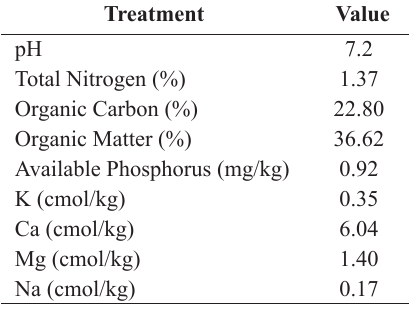
Table 2: Analysis of organic fertilizer used for the